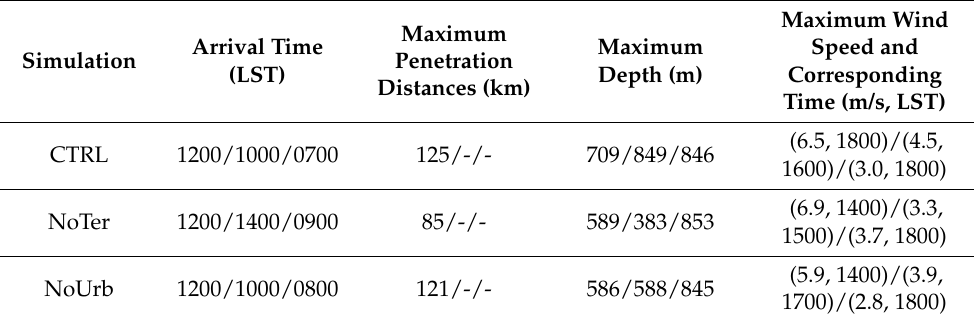
Table 2. Statistics characteristics of the sea breeze of the three experiments (Line AB/Line CD in the east coast/Line CD in the west